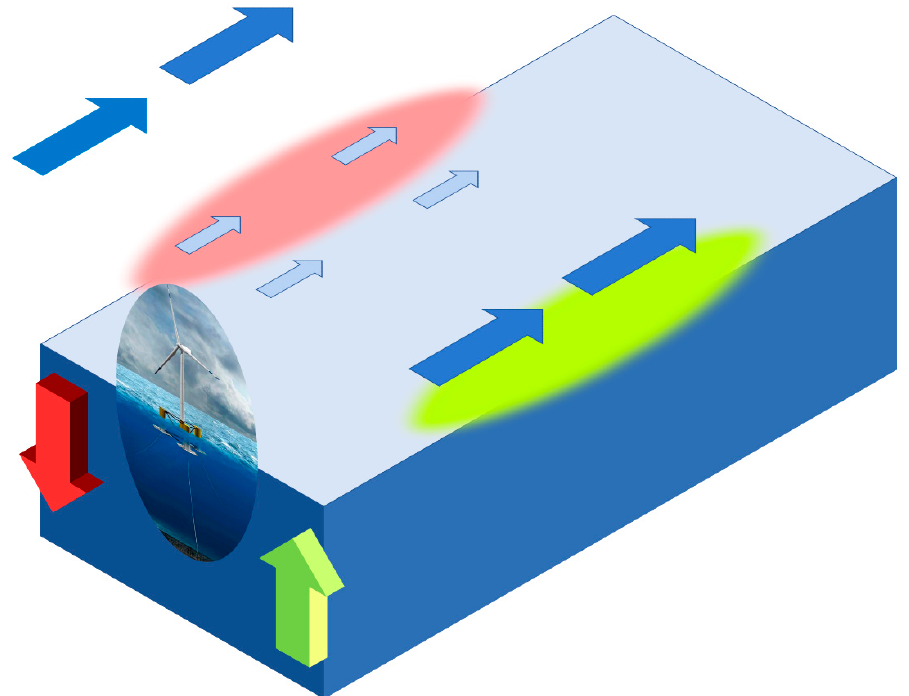
Figure 1. Schematic diagram for the mechanism of marine vertical response to the wind-forcing deficit on the leeward side of a wind turbine. The blue arrows indicate wind stress. The wind stress outside the wind turbine is undisturbed and large, but it is small behind the wind turbine due to the energy extraction. The green and red arrows represent the upwelling and downwelling currents,